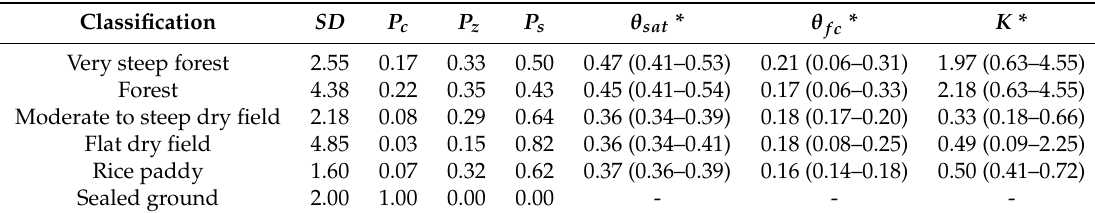
Table 2. Typical soil characteristics of each represented soil class of the Haean catchment from a 2009 catchment-wide field survey from TERRECO project.